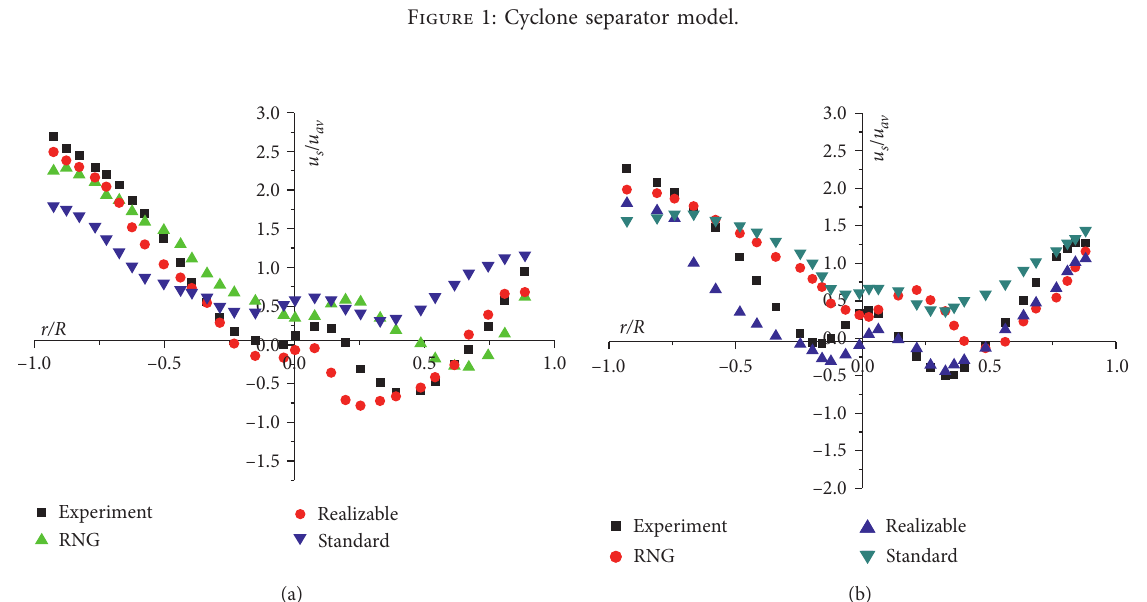
Figure 1: Cyclone separator model.